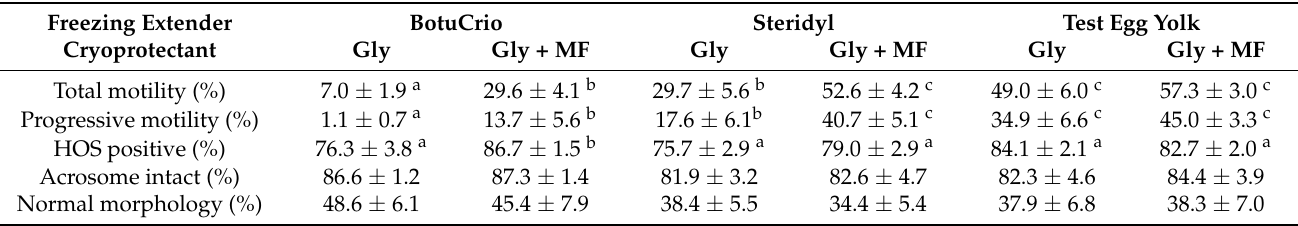
Figure 1. Open castration in a giraffe: ( a ) Opened processus vaginalis and protruding testis before surgical removal. ( b ) Giraffe testis, epididymis, and duct deferens. ( c ) Dissected cauda epididymis and ductus deferens. Table 3. Giraffe epididymal sperm characteristics ( n = 7) post-thaw using glycerol and a mix of glycerol and methylformamide as cryoprotectants. Gly: 5% glycerol; Gly + MF: 1% glycerol + 4% methylformamide. Data are pooled over n = 7 males ± SEM. Columns which differ in superscript indicate significant differences between treatments ( p < 0.05).